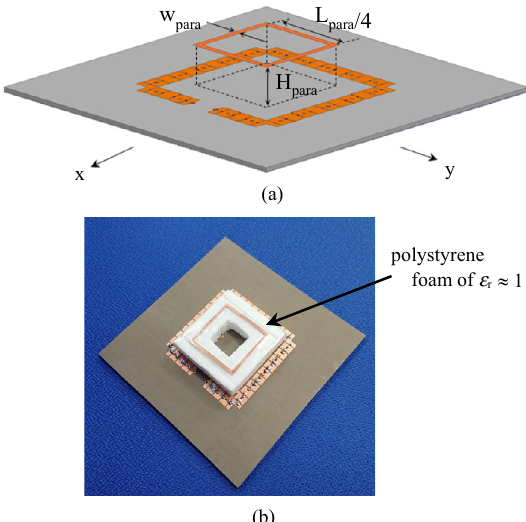
Fig. 5. Metaloop with a parasitic natural conducting loop. (a) Perspective view. (b) Fabricated